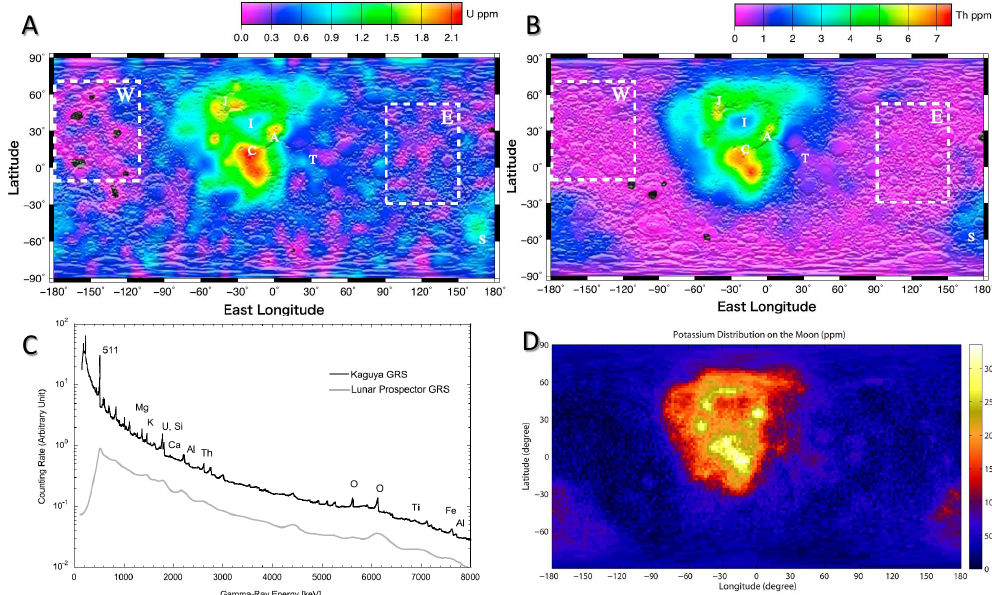
Figure 7. New Measurements of incompatible elements with modern sensors. ( A ) Uranium distribution exhibits spatial differences within farside highlands (Source: [131]) . ( B ) Spatial distribution of thorium (Source: [131]) . ( C ) Improvement in spectral resolution between Kaguya and Lunar Prospector Gamma ray spectrometers (Source: [131]) . ( D ) Spatial distribution of potassium correlates well with the thorium distribution (Source: [132])